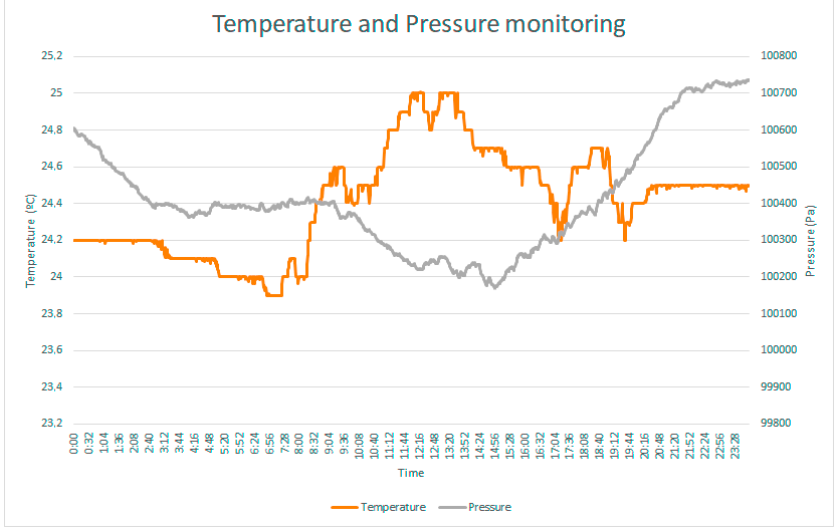
Figure 12. Evolution of temperature and pressure monitored by sensor prototype.